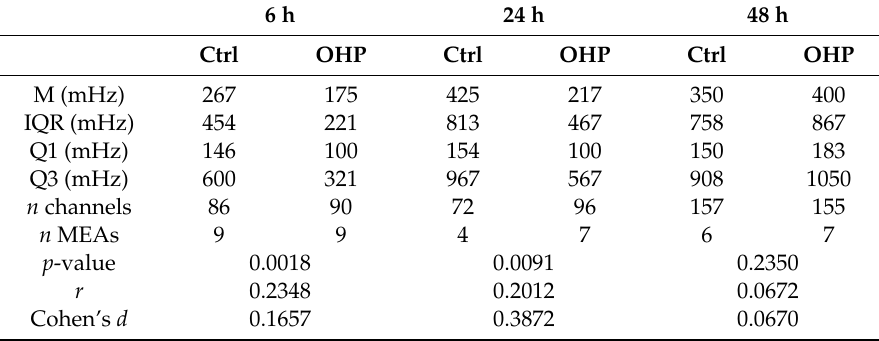
Table 1. Descriptive and inferential statistics about the electrical response of dorsal root ganglion (DRG) 1min-window, startingfromthebeginningoftheagonistperfusion. IQR,Q1, andQ2aretheinterquartile range, the first and the third quartiles, respectively. Below are the number of